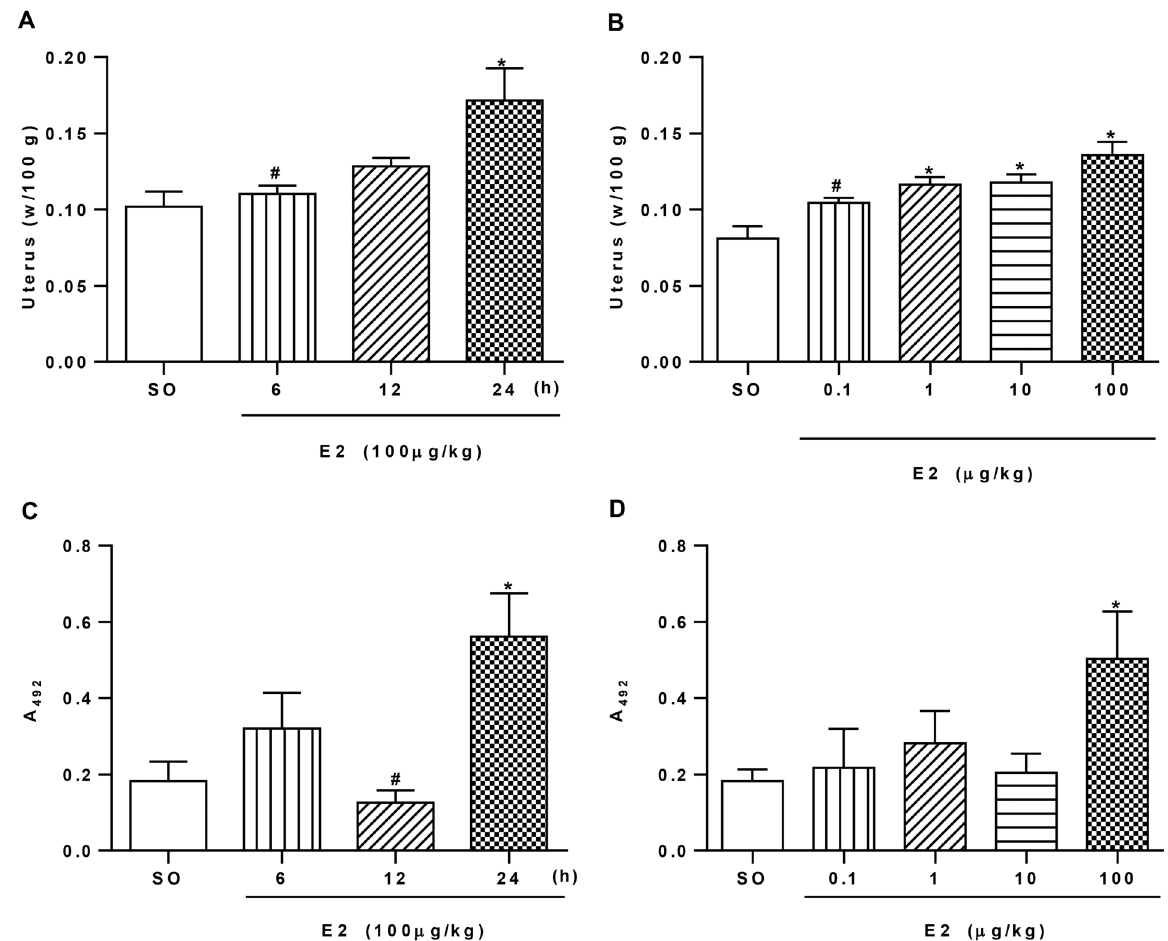
Figure 1. Time and dose of 17- b -estradiol (E2) that promoted edema and eosinophil migration to the uterus. A , The uterus of animals injected with E2 (100 m g/kg, sc ) was collected and weighed (w) 6, 12, and 24 h after injection. The sesame oil group (SO, sc ) was used as control. B , E2 doses of 0.1, 1, 10, and 100 m g/kg (n=10/group) were given and the uterus was collected and weighed 24 h later. C and D , The uteruses of the two experiments were used for the eosinophil peroxidase assay, reported as absorbance (A 492 ). Data are reported as means ± SE (3 independent experiments; n=5). *P o 0.05 compared with SO group. # P o 0.05 compared with E2 dose in 24 h (one-way ANOVA with Tukey post hoc